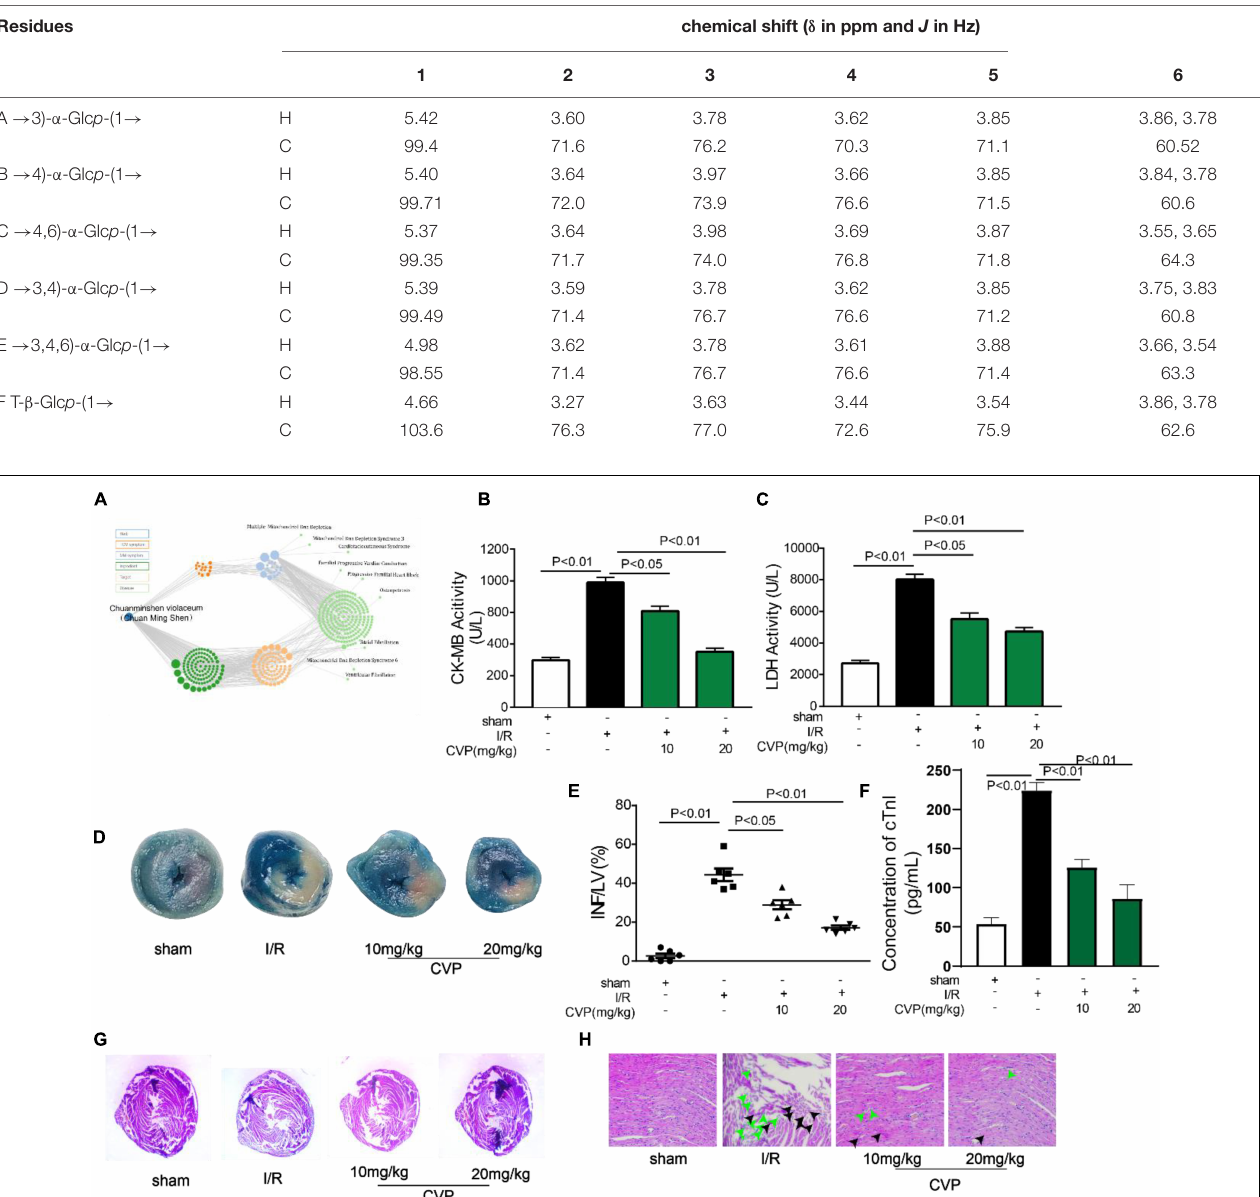
TABLE 2 | H-NMR and C-NMR spectra’s chemical shift of Chuanminshen violaceumis polysaccharide (CVP). Residues